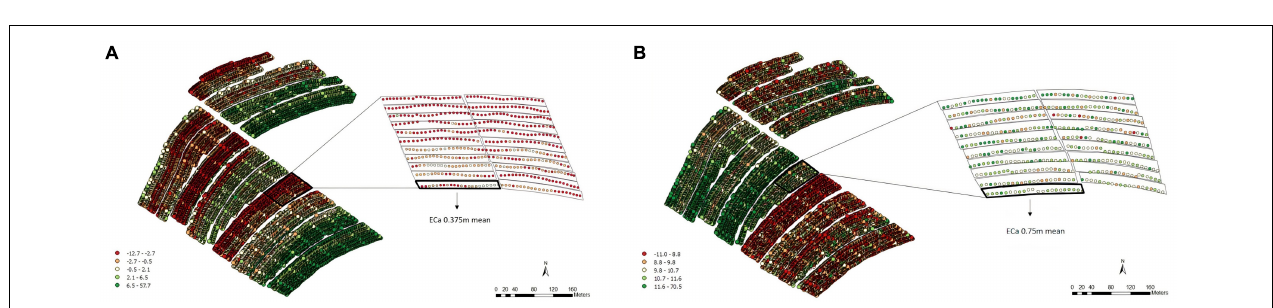
FIGURE 4 | Thematic map generated by inverse distance weighting (IDW) and overlap of the experimental plots on the interpolated map and the average values of the points of interest for principal component 1 – PC1 (A) and principal component 2 – PC2 (B) , Experimental Area 2.